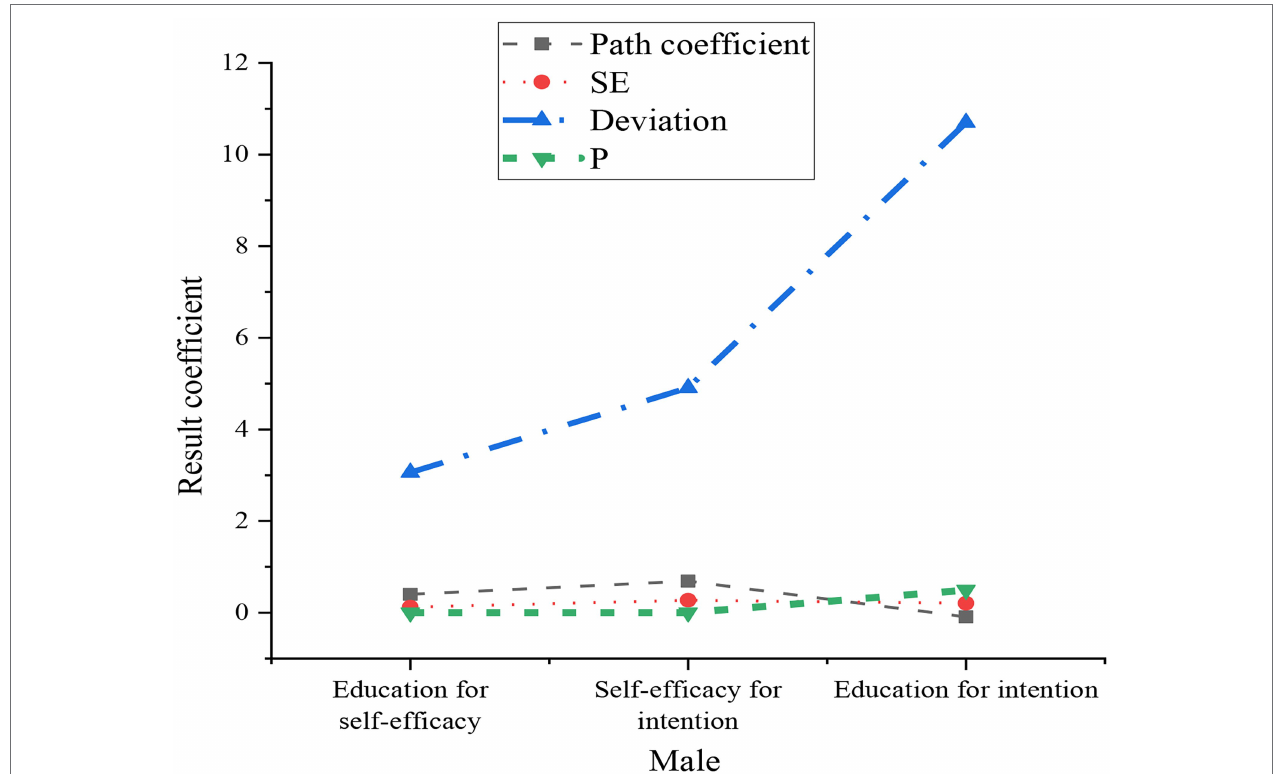
FIGURE 9 | Estimated results of the male sample group.